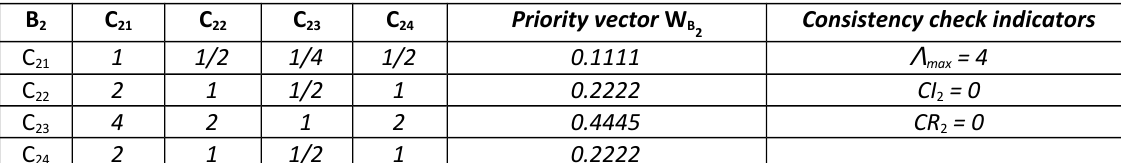
Table 5. Alternative matrix B